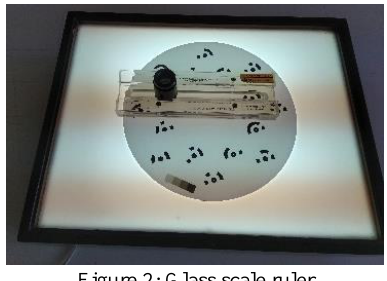
Figure 2: Glass scale ruler A Canon EOS 6D DSLR camera with a full-frame sensor, fixed on a tripod, with a Canon EF 135mm lens providing an f/2 maximum aperture was utilised. The aperture was set to its smallest possible value (f/32) for achieving a greater depth of field (DoF). The shutter speed was set to ¼ sec and the ISO was set 100 to minimize the sensor’s noise and no flash was used. Also, the XRite Color Checker Classic (XRite chromatic scale, 2019) was employed for the white balance and for rendering the correct colour. For achieving the